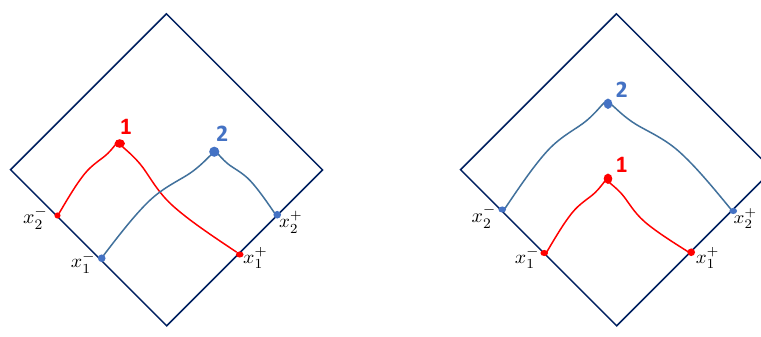
Figure 1 . In a topological CFT, local operators are attached to two Wilson lines that connect to past null in(cid:12)nity. Whether two operators are space-like or time-like separated is a topological dis- tinction, encoded via the relative ordering of the asymptotic end-points x (cid:6) Wilson lines. The lines are shown with zigzags to indicate that the bulk has no (cid:12)xed metric. orders the operators according to increasing light-cone time